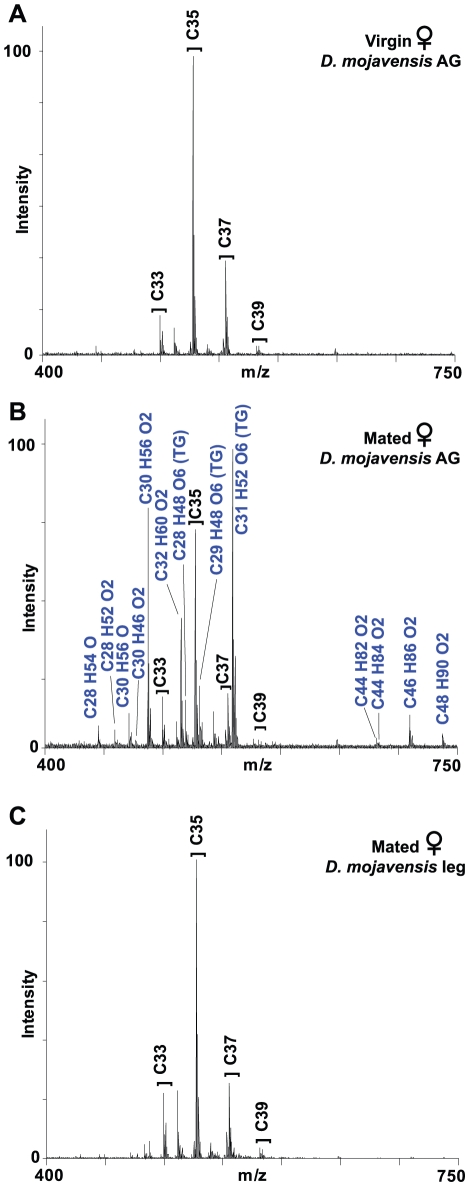
Transfer of male D. mojavensis compounds to females during mating.UV-LDI mass spectra of female D. mojavensis before (A) and after mating (B, C) show that 13 CHCs and triacylglycerides (TG), specific to the male anogenital region, are transferred to the female anogenital (AG) region but not the legs (B, C). Male-specific AG compounds are labeled in blue. See Table 5 for CHC and triglyceride designations.